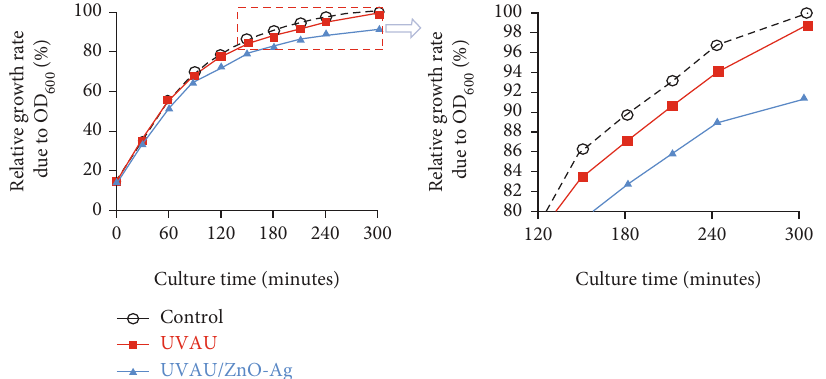
Figure 10: The growth rate of E. coli bacteria in liquid culture without (control) or with the presence of the coating fi lms not containing (UVAU) or containing 2wt% ZnO-Ag nanohybrids